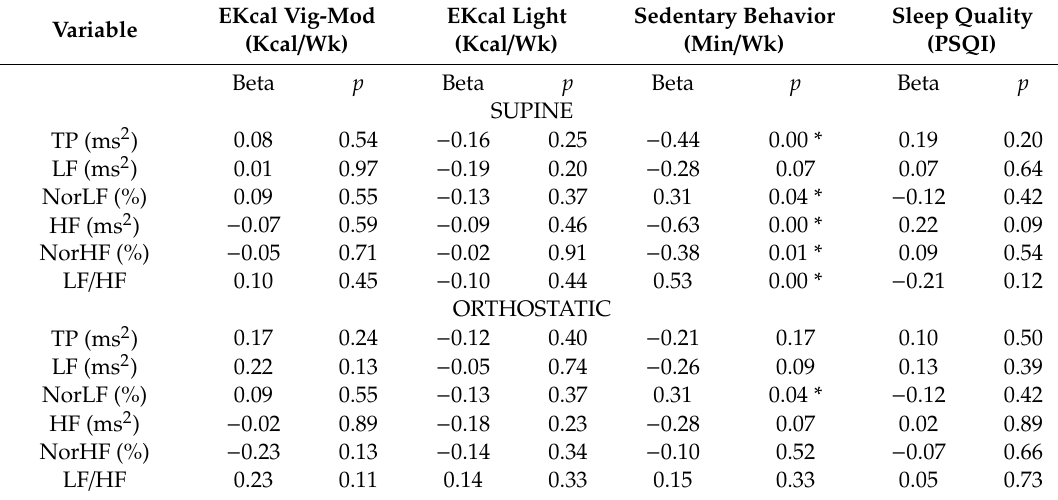
Table 3. Standardized regression coefficient (Beta) and significance ( p ) for each analyzed variable of the crude model, in relation to the heart rate variability in the supine and orthostatic positions . EKcal Vig-Mod EKcal Light Variable (Kcal/Wk) (Kcal/Wk) (Min/Wk)